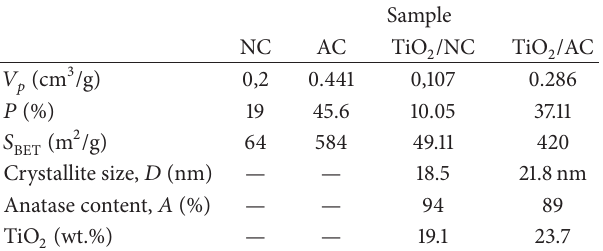
Table 1: Textural and structural properties of the